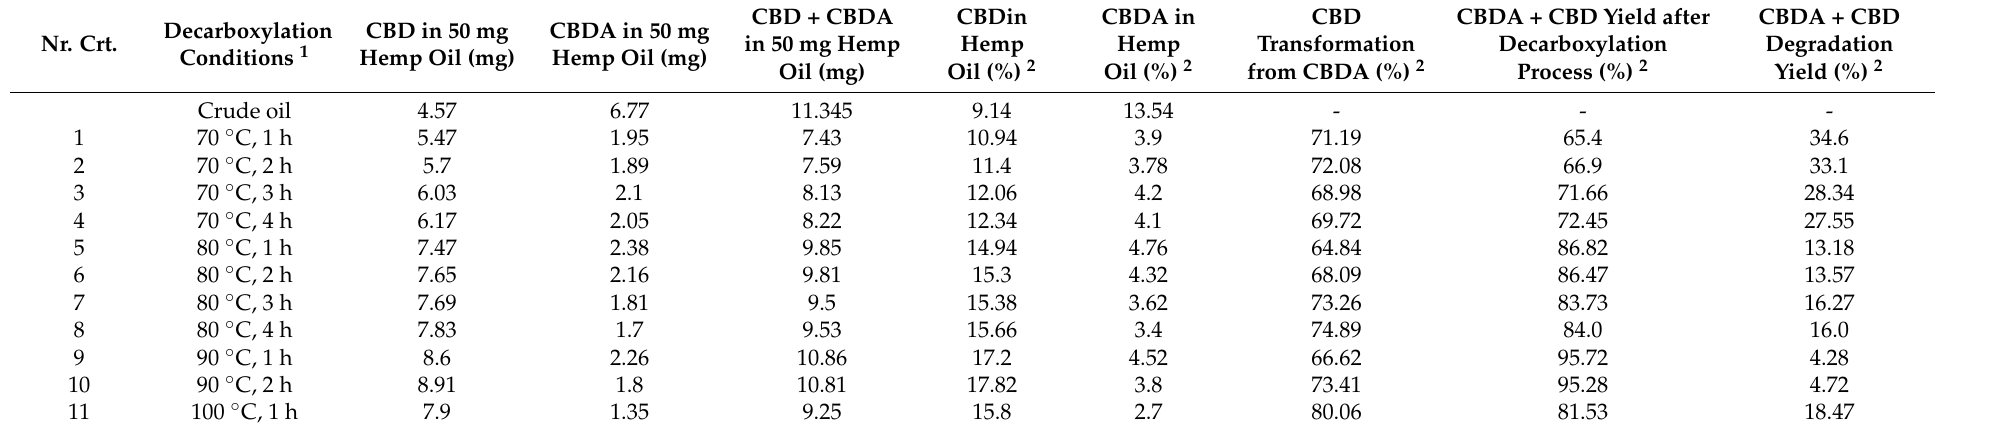
Table 2. Experimental results after decarboxylation in soft conditions of CBDA from hemp